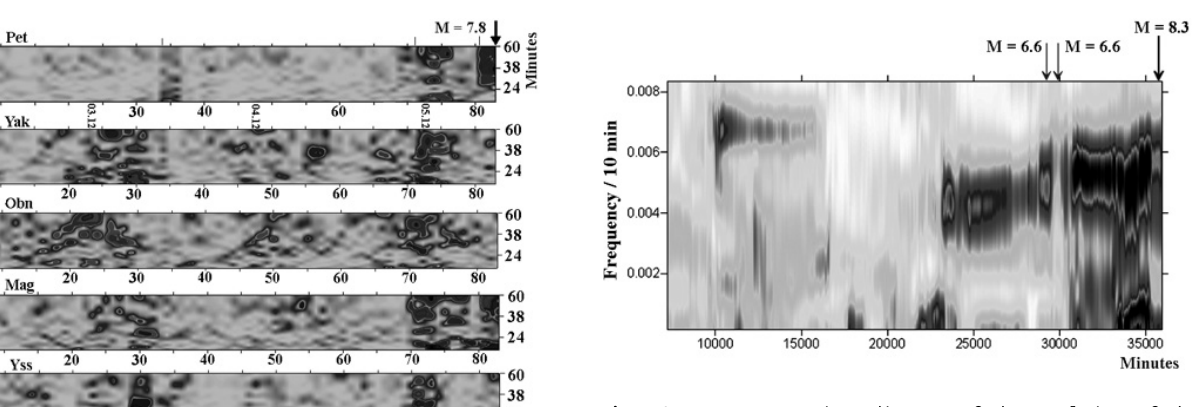
Fig. 16. Frequency-time diagram of the evolution of the spectral measure of coherence λ(t,ω) for seismic records of the stations YSS (46.57 ◦ N–142.45 ◦ E), MDJ (44.37 ◦ N–129.35 ◦ E), INC (37.29 ◦ N–126.38 ◦ E). Arrows indicate successively time moments of 2 remote earthquakes ( M = 6 . 6) and of the Hokkaido earthquake, M = 8 . 3, (41.81 ◦ N–143.91 ◦